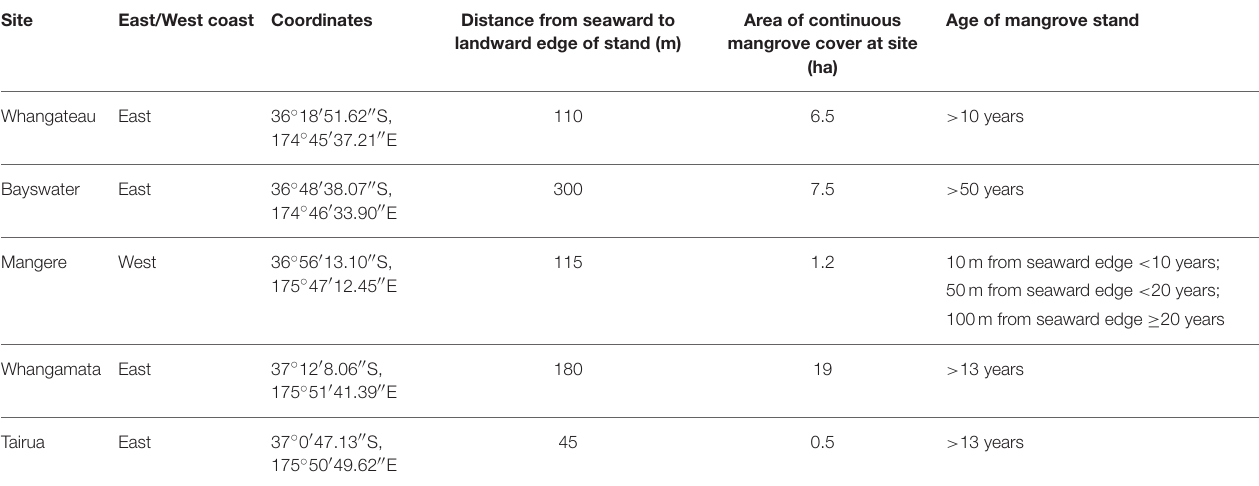
TABLE 1 | Location, age, and area of the study sites. Site East/West coast Coordinates Distance from seaward to